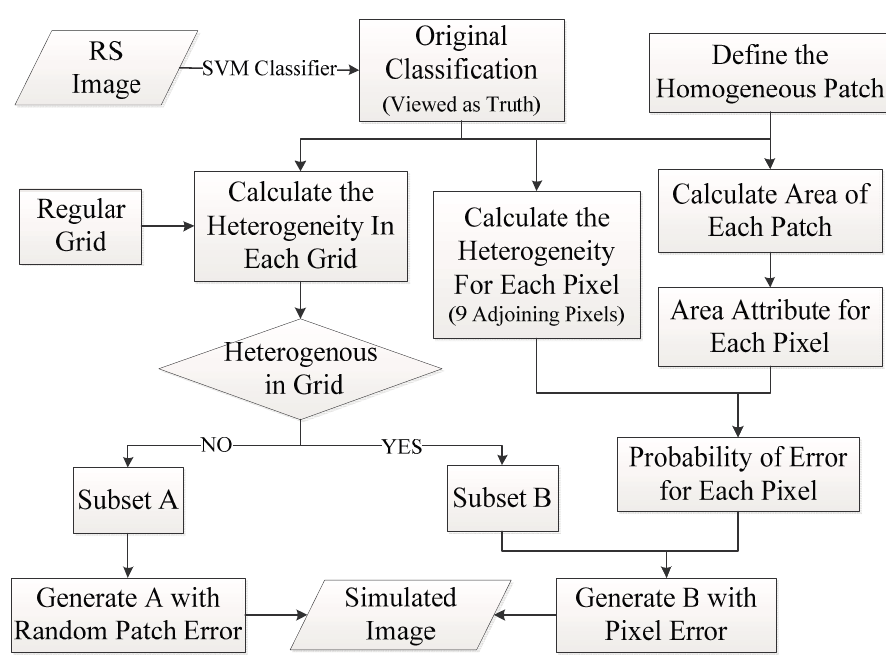
Figure 2. Simulation procedure.